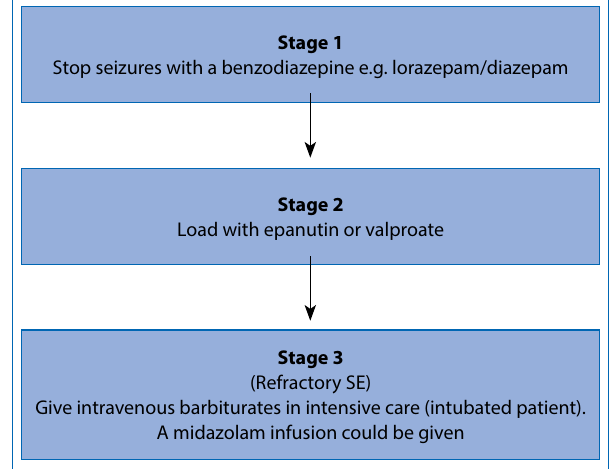
Figure 2. Stages of treatment of SE. Metabolic abnormalities, e.g. hypoglycaemia and acidosis should be considered and